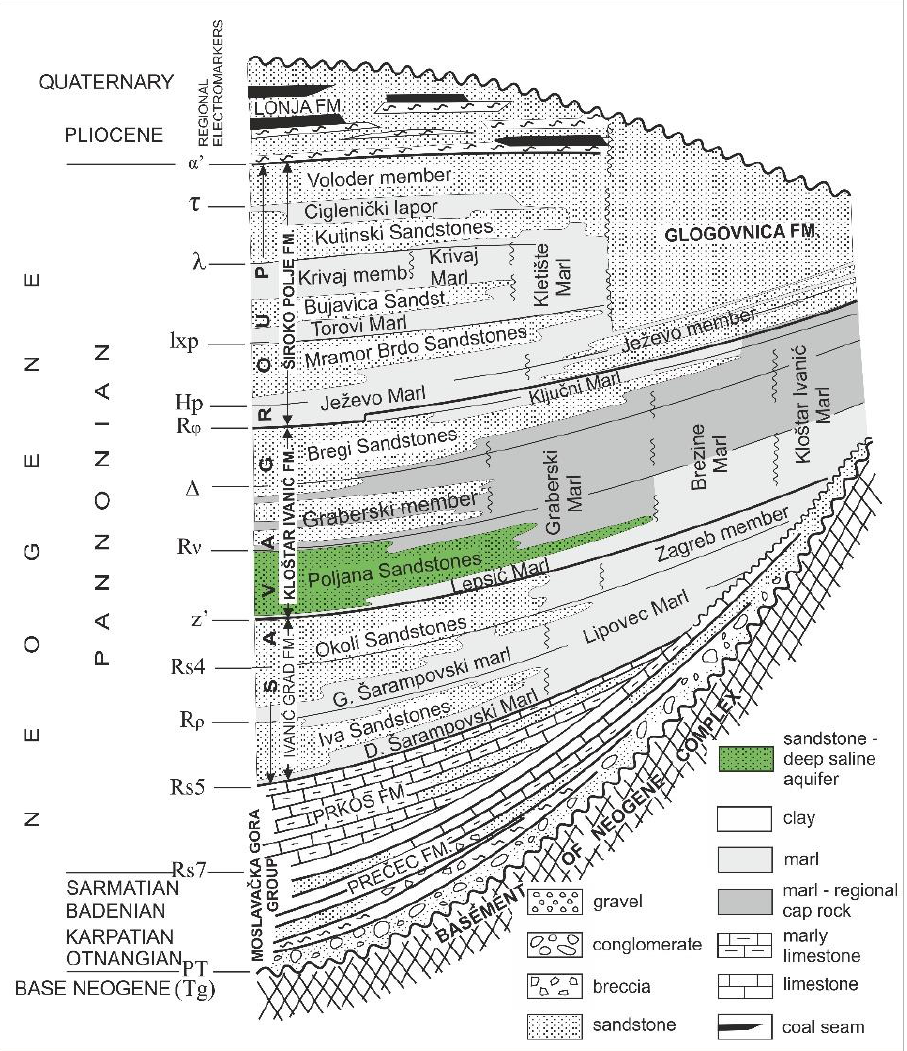
Figure 1. Schematic lithostratigraphic column of the Sava depression (modified after [38]) with marked DSA Poljana in Poljana Sandstones.